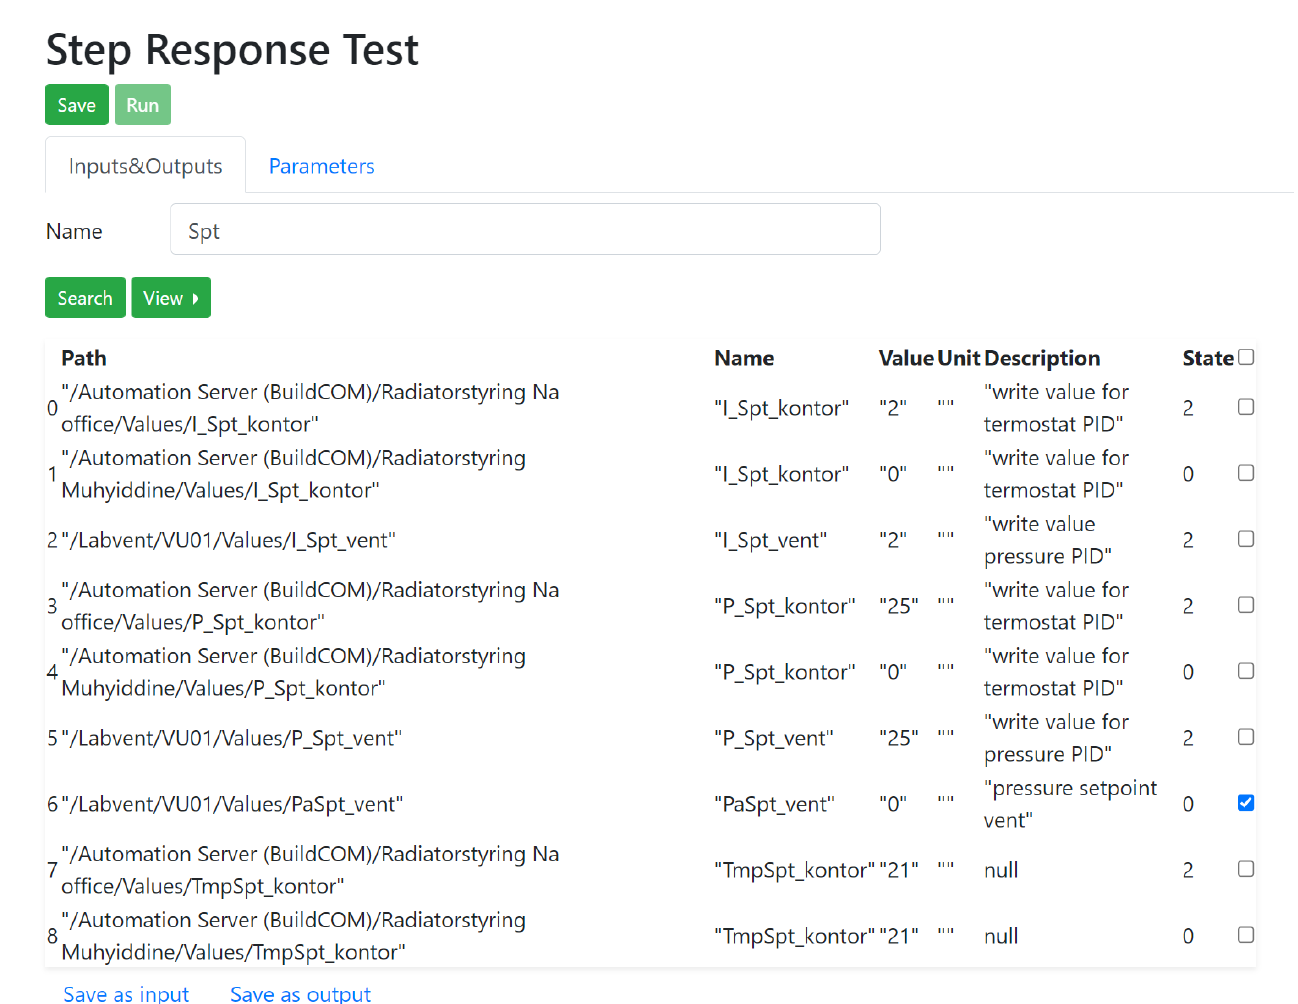
Figure 5. Example of searching in